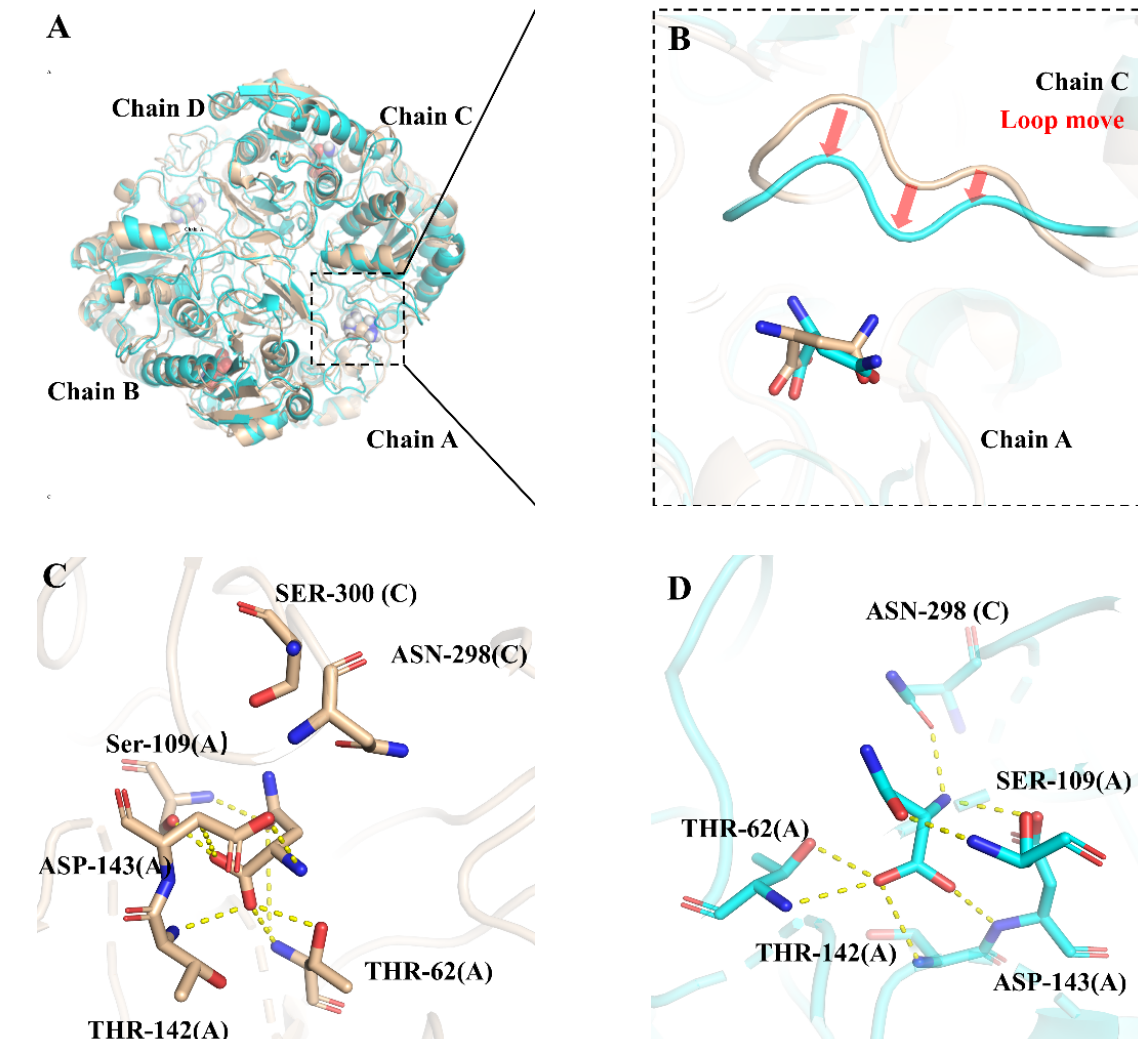
Figure 5. The top 10 residues that contribute to protein and substrate binding.